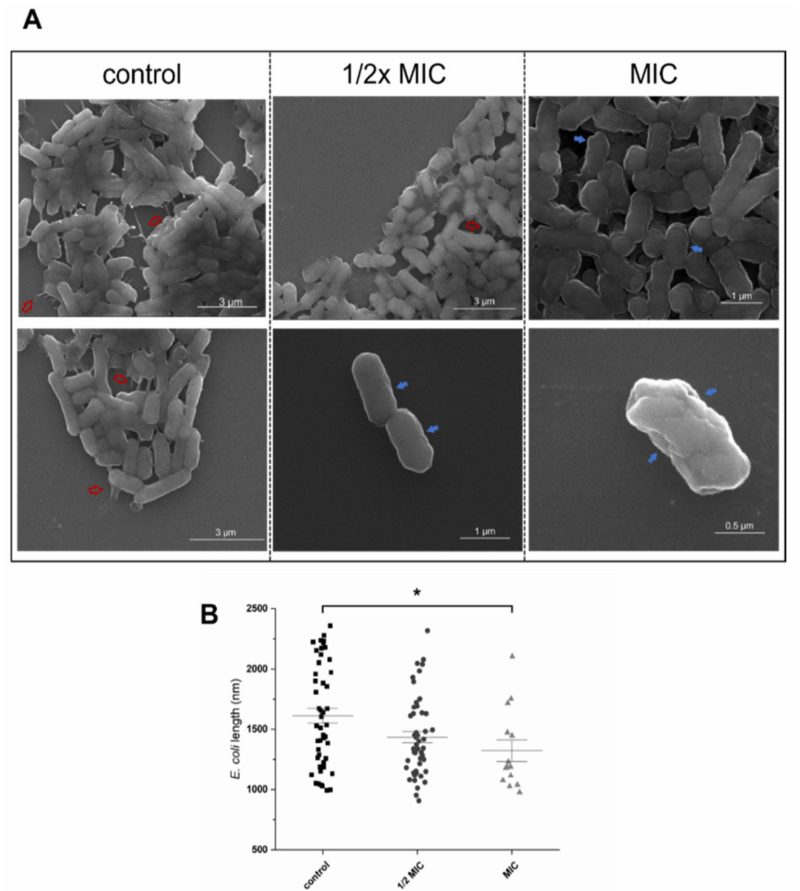
Figure 3. ( A ) SEM images obtained for untreated E. coli (control) and treated at 1/2 × MIC and MIC of complex 1b . Red hollow arrows indicate the presence of biofilm matrix; blue filled arrows indicate damage of the cell membrane. ( B ) Size distribution (length) of E. coli bacteria untreated (control) or treated with complex 1b at its 1/2 × MIC and MIC. * p <